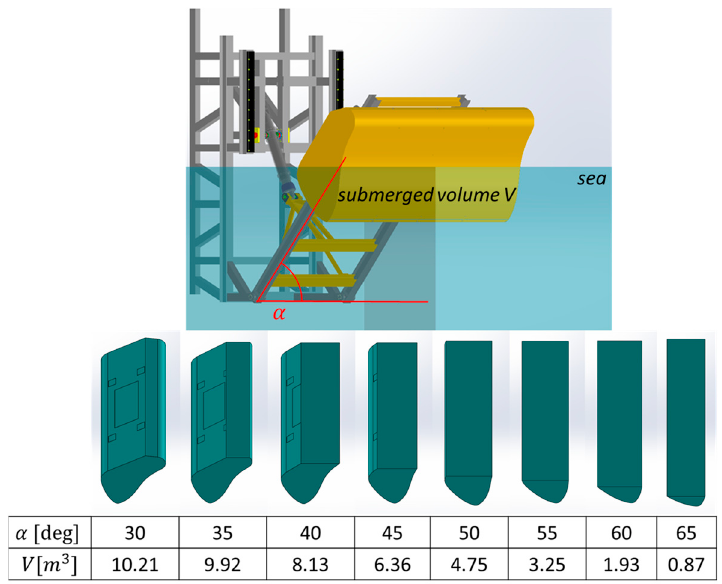
Figure 3. Volume of water displaced by the floating buoy.